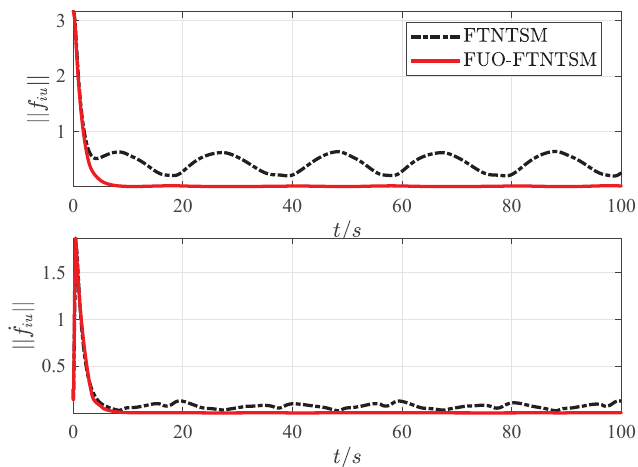
Figure 13. Norm of tracking errors and their